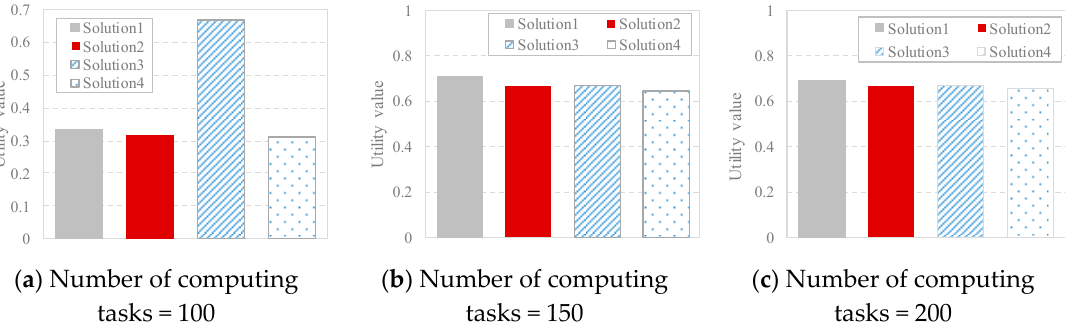
Figure 3. Comparison of the utility value of the solutions generated with different task scales by IOM.